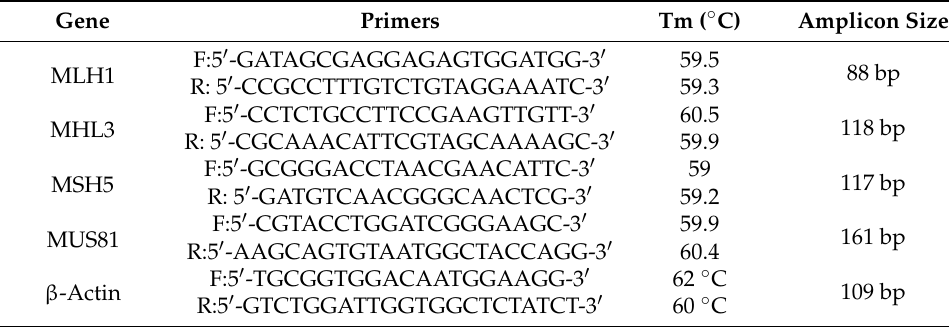
Table 2. Primer set used for quantitative